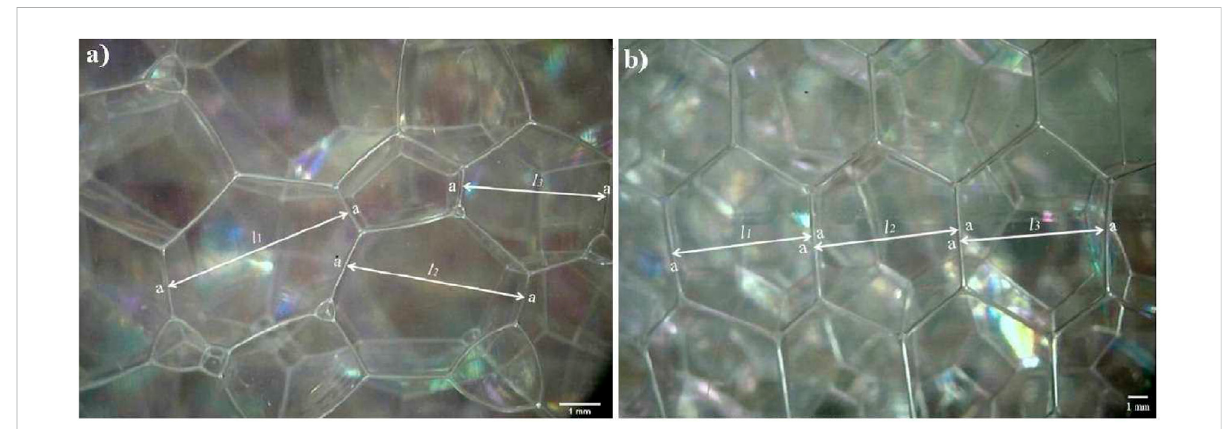
FIGURE 9 Photographic picturesshowingasmallregionofafoamformedinside (A) Pipe2withtopopenand (B) Pipe5withtopclosed. Thewhitearrows